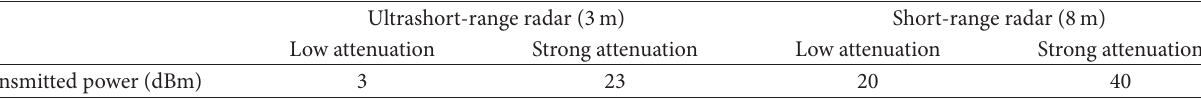
T 2: Detection range versus transmitted